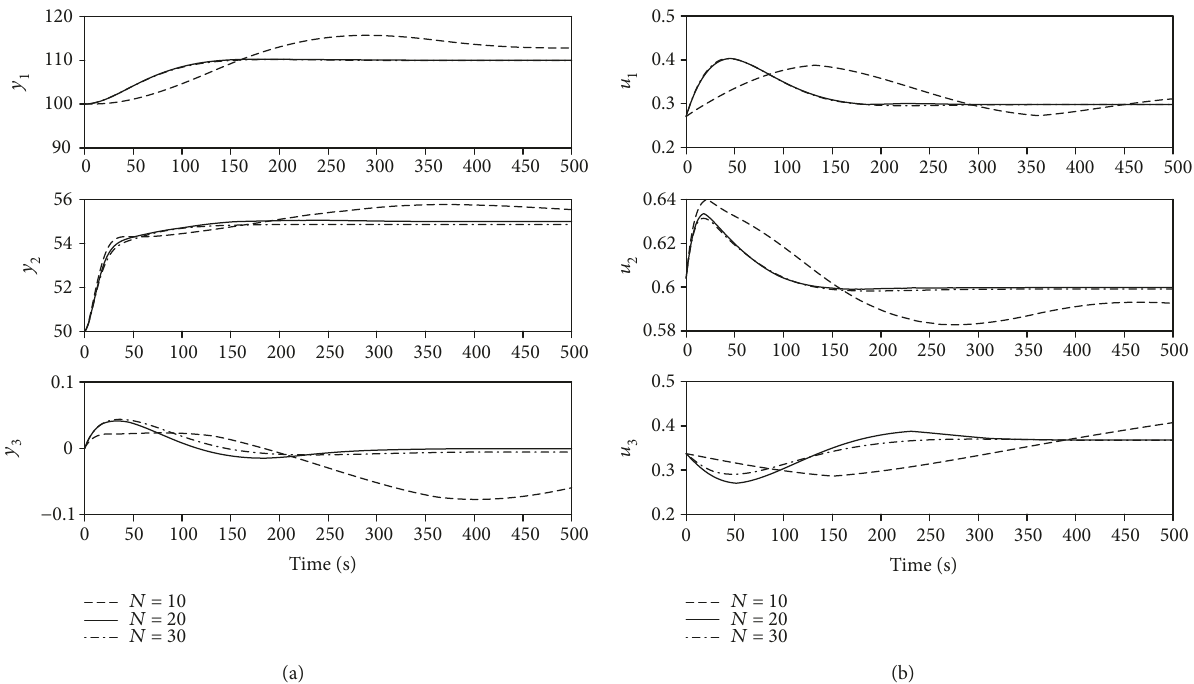
Figure 5: Outputs and controls of the unit when taking di ff erent number N of nodes.